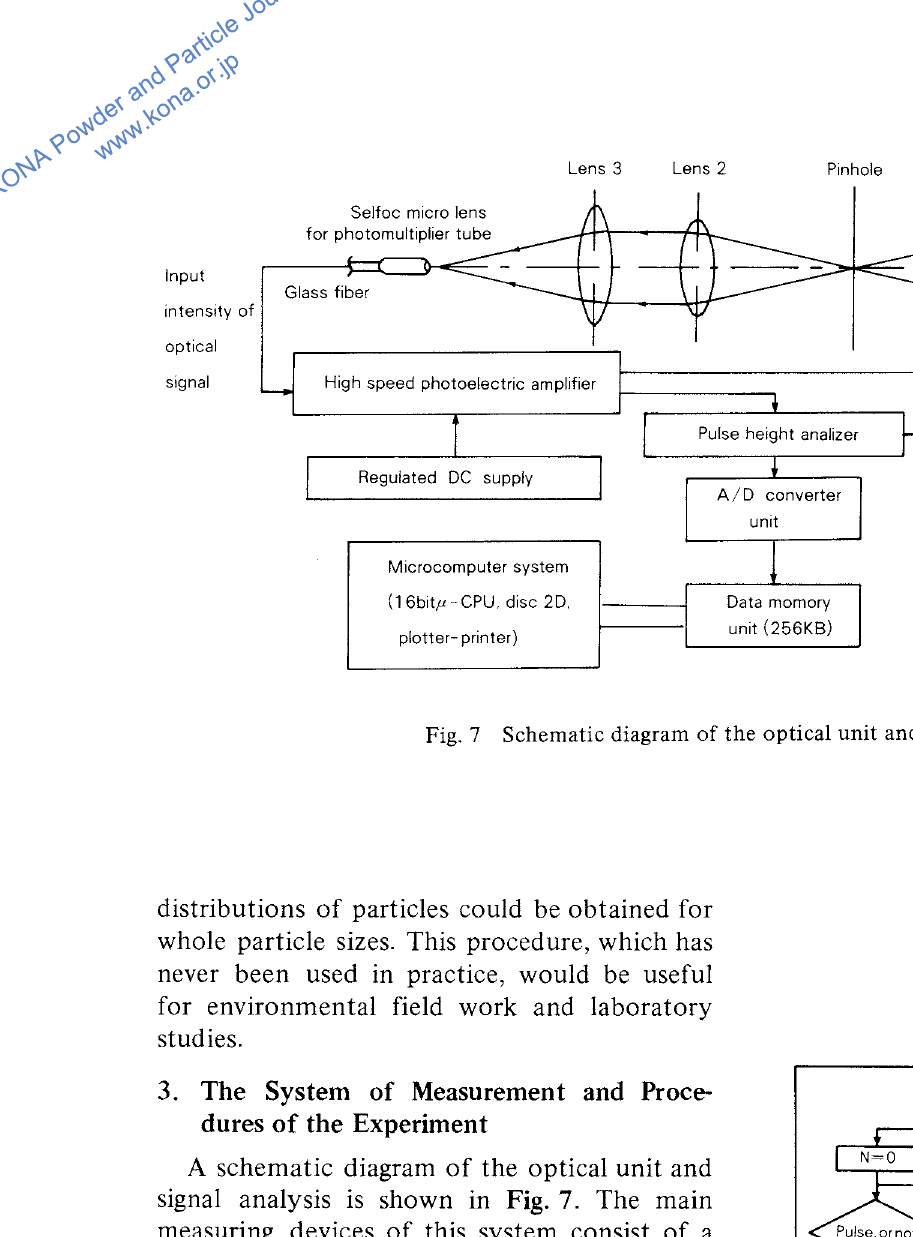
Fig. 7 Schematic diagram of the optical unit and signal analysis